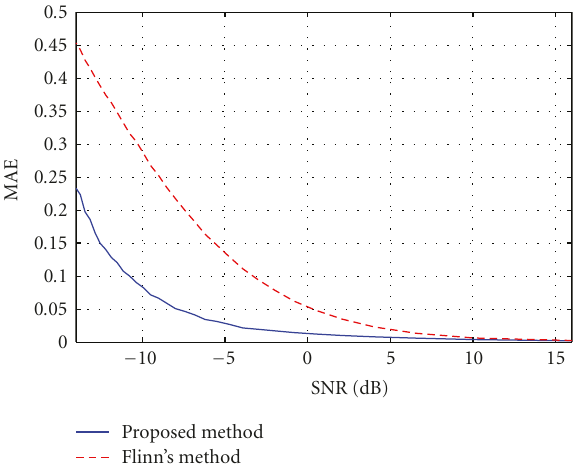
Figure 3: Mean Absolute Error for estimation of phase shift between components for various SNRs (plain line: MWSM based method; dotted line: Flinn’s method).